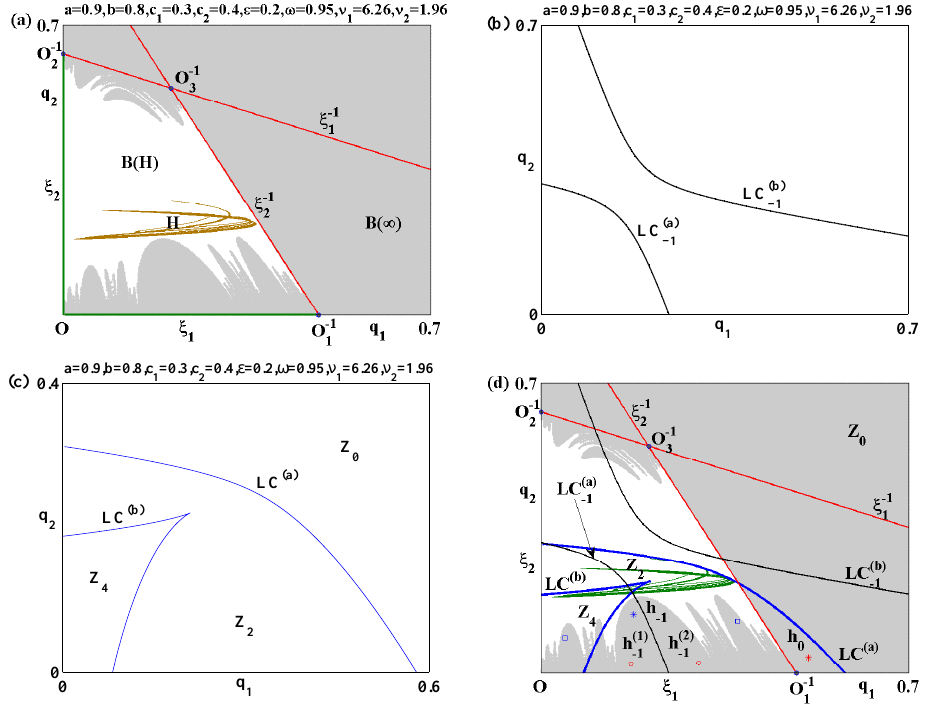
Figure 3. At the parameter values of a = 0.9, b = 0.8, c 1 = 0.3, c 2 = 0.4, (cid:101) = 0.2, ω = 0.998, ν 1 = 6.26 and ν 2 = 1.96. ( a ) Basin of attraction for a chaotic attractor. ( b ) The two branches of LC − 1 . ( c ) The two branches of LC . ( d ) The change in the shape of B ( ∞ ) from a connecting set to a disconnecting one for a chaotic